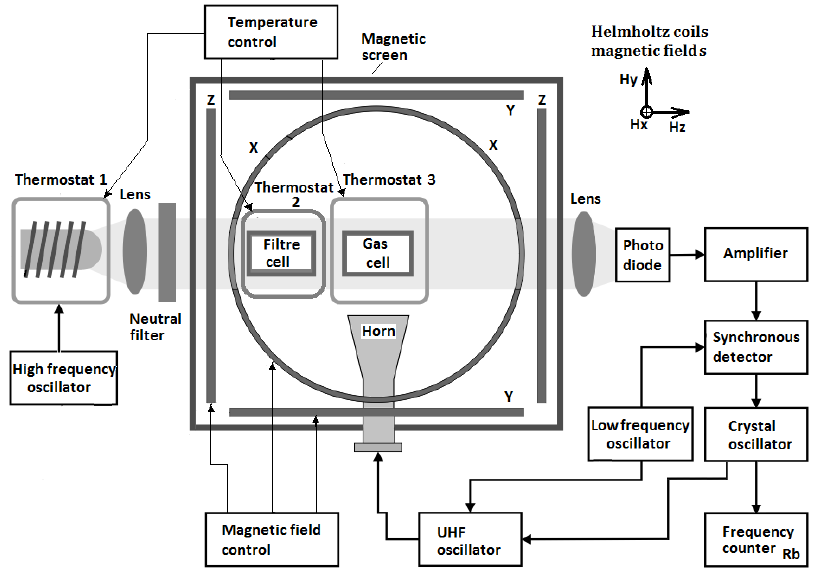
Figure 1. Laboratory setup used to study the frequency light shift in a rubidium atomic clock. The frequency counter is synchronized by rubidium atomic clock.